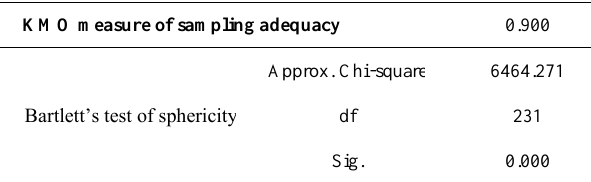
Table 4. KMO and Bartlett’s test of